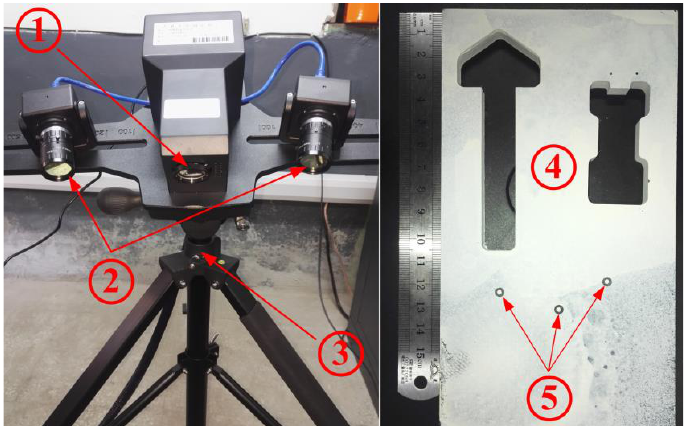
Figure 12. The photograph of experimental setup for collecting point cloud data of complex-shaped object. 1 — Structured light laser; 2 — Double cameras; 3 — Tripod platform; 4 — Complex workpiece; 5 — Marked points.